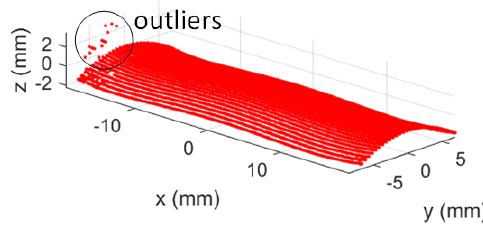
Figure 23. Measurement result with outliers of the laser sensor.